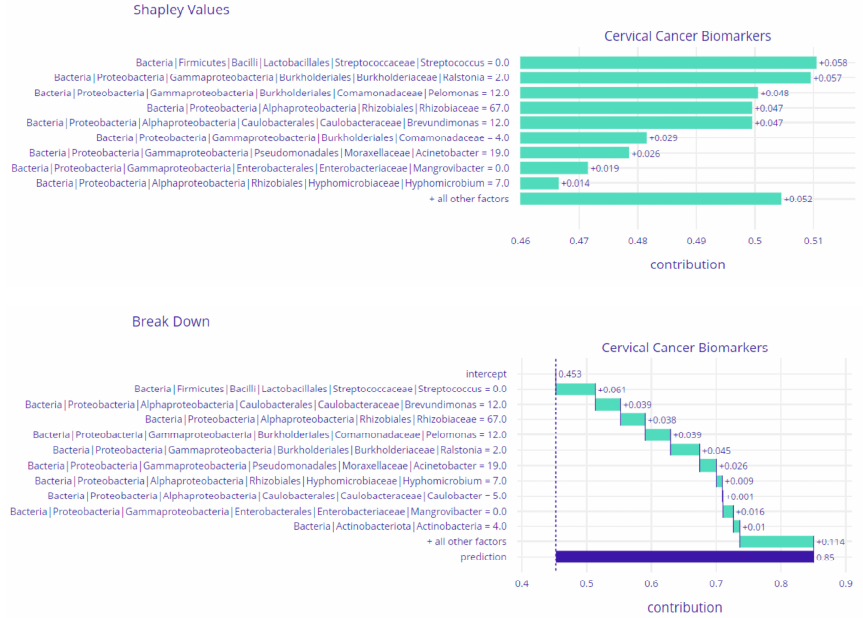
Figure 11 . The SHAP explanations for the healthy control group, where the bar plots represent feature significance using SHAP values and feature breakdowns, respectively. The green patterns illustrate the substantial increase in average response for each feature.